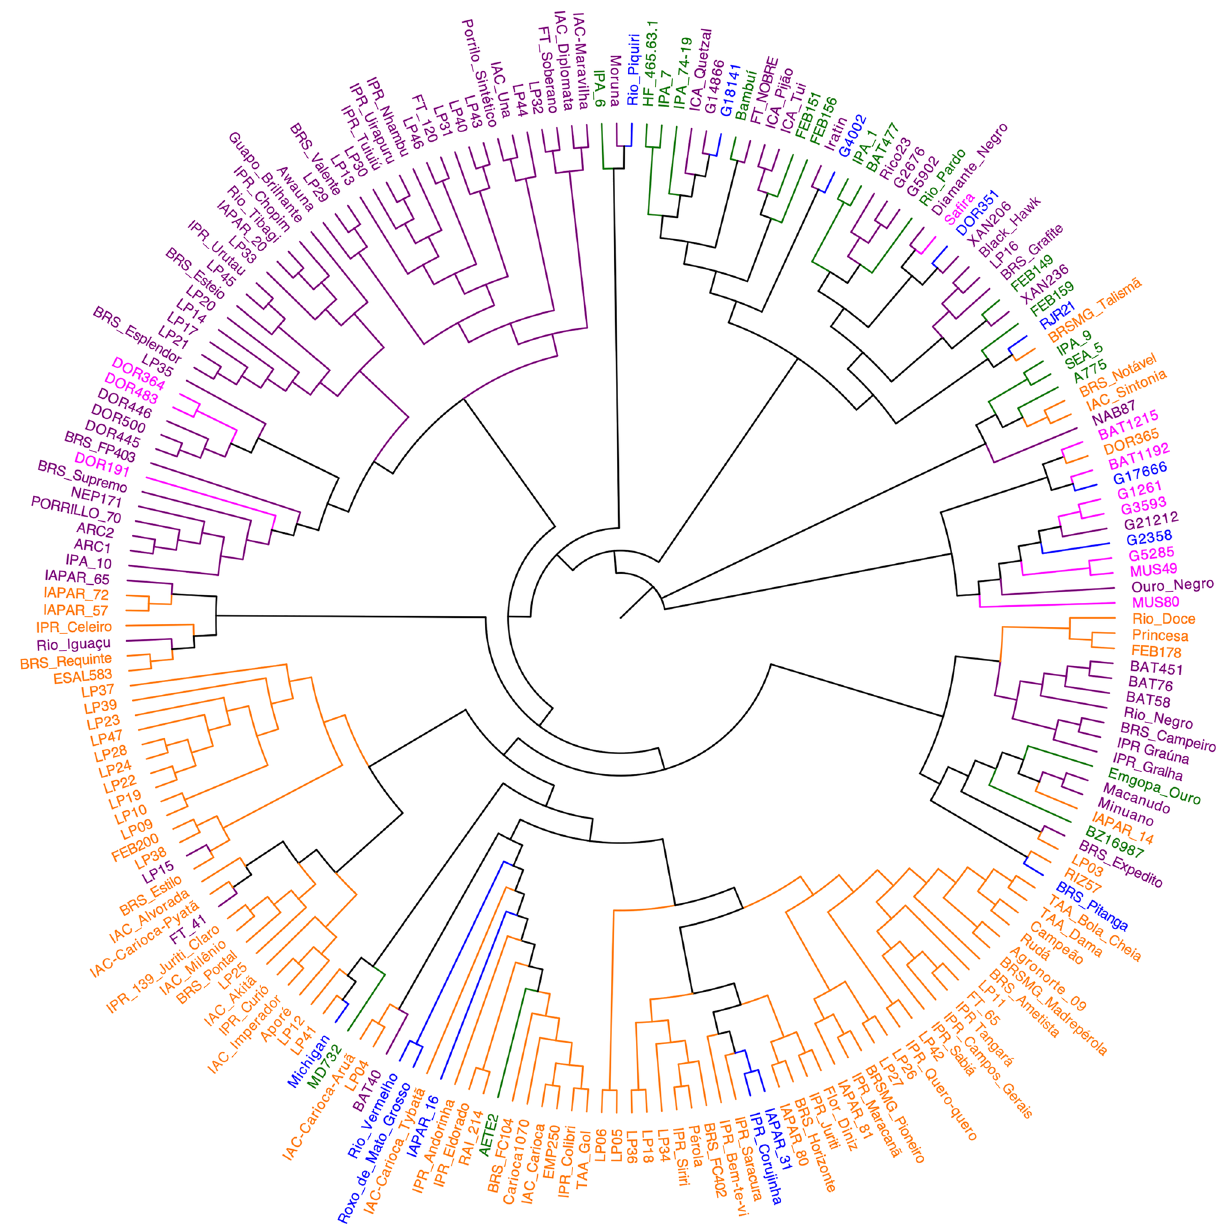
Figure 5. Dendrogram showing the genetic relatedness among 207 common bean accessions belonging to the Brazilian Diversity Panel. The different colors identify the accessions according to the color of the seed tegument. Purple = black tegument, Orange = carioca-type tegument, Green = cream tegument, Pink = red tegument, and Blue = others. Figure produced in FigTree